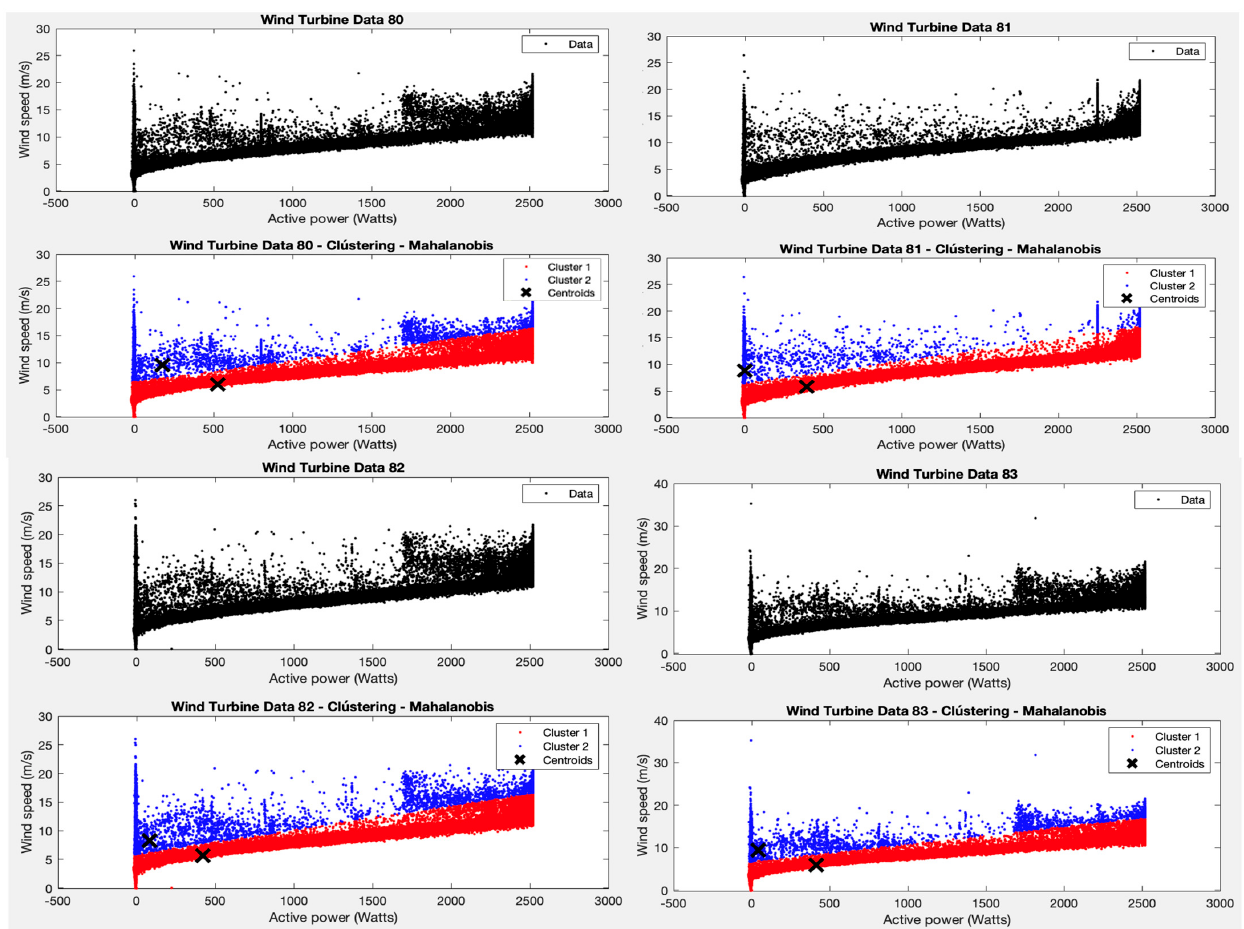
Figure 4. Test 2 results.